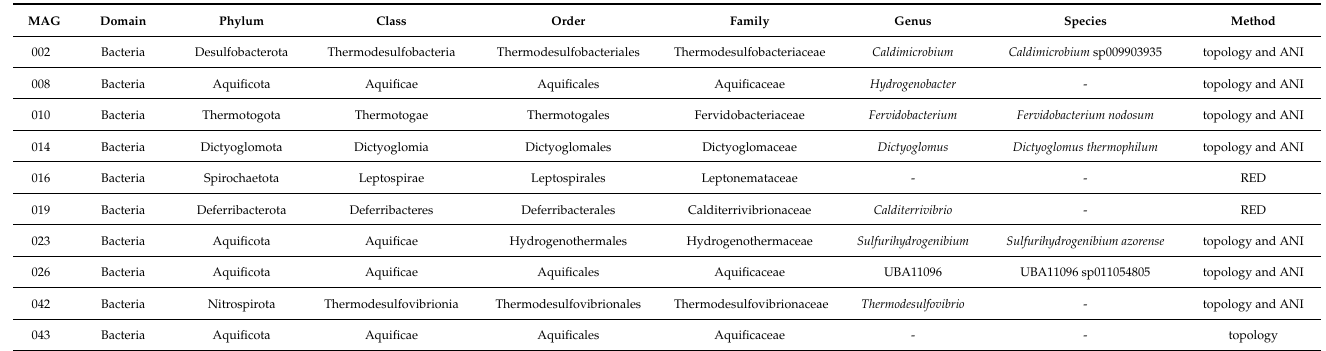
Table 1. GTDB-Tk taxonomic assignment of MAGs.